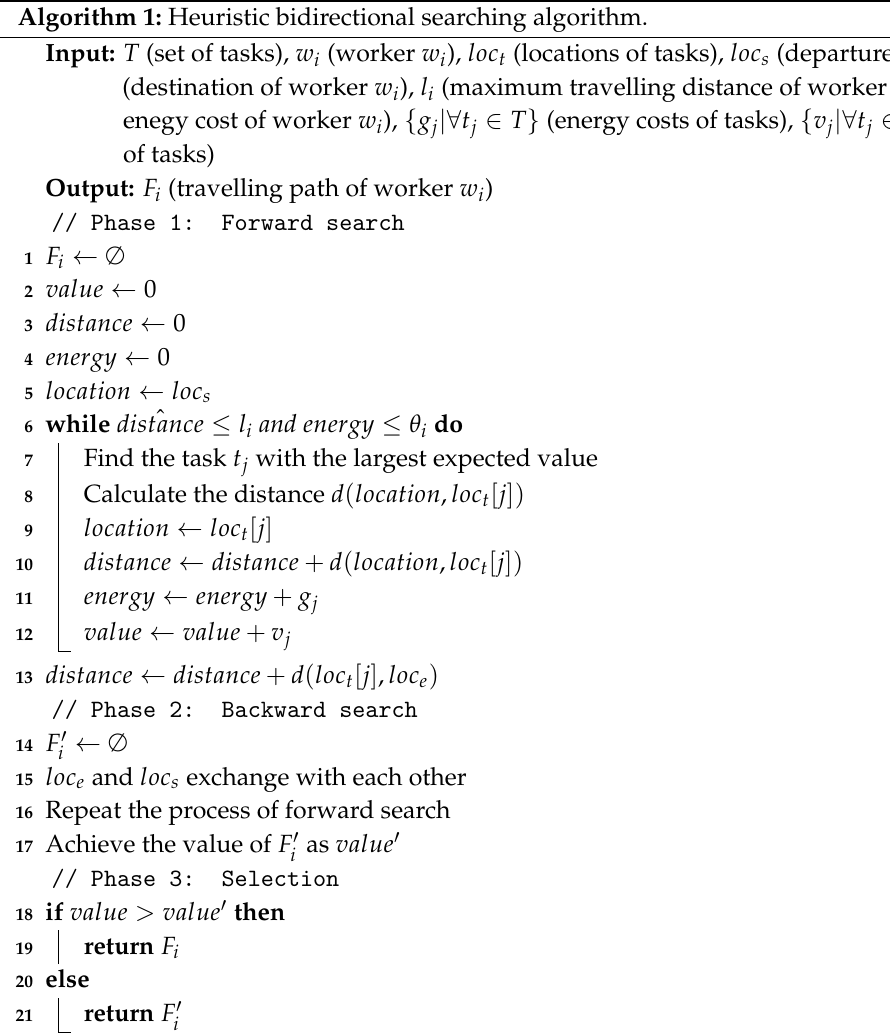
Algorithm 1: Heuristic bidirectional searching